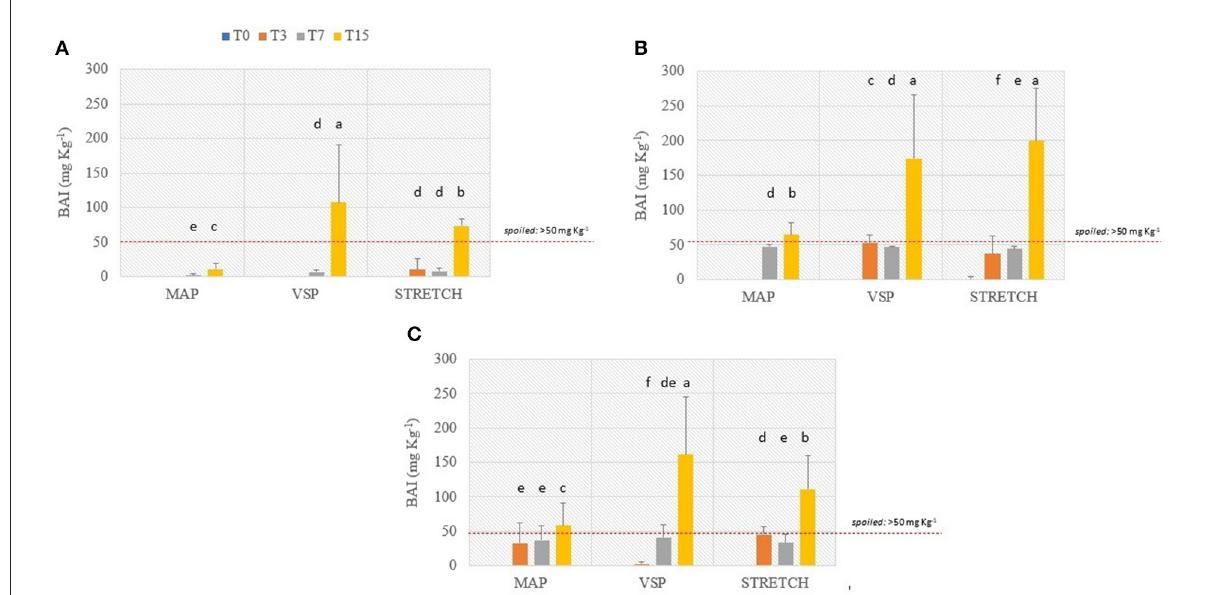
FIGURE7 Results of biogenic amines index (BAI, mg kg − 1 ) in breast (A) , in drumstick (B) , and leg (C) of chicken meat; data were observed during the refrigerated storage time (0, 3, 7, and 15 days, at 4 ◦ C) of samples packaged modified atmosphere (MAP), in air (STRETCH), and under vacuum (VSP). In each graph, data signed with different letters are significantly different (LSD test, p < 0.05).